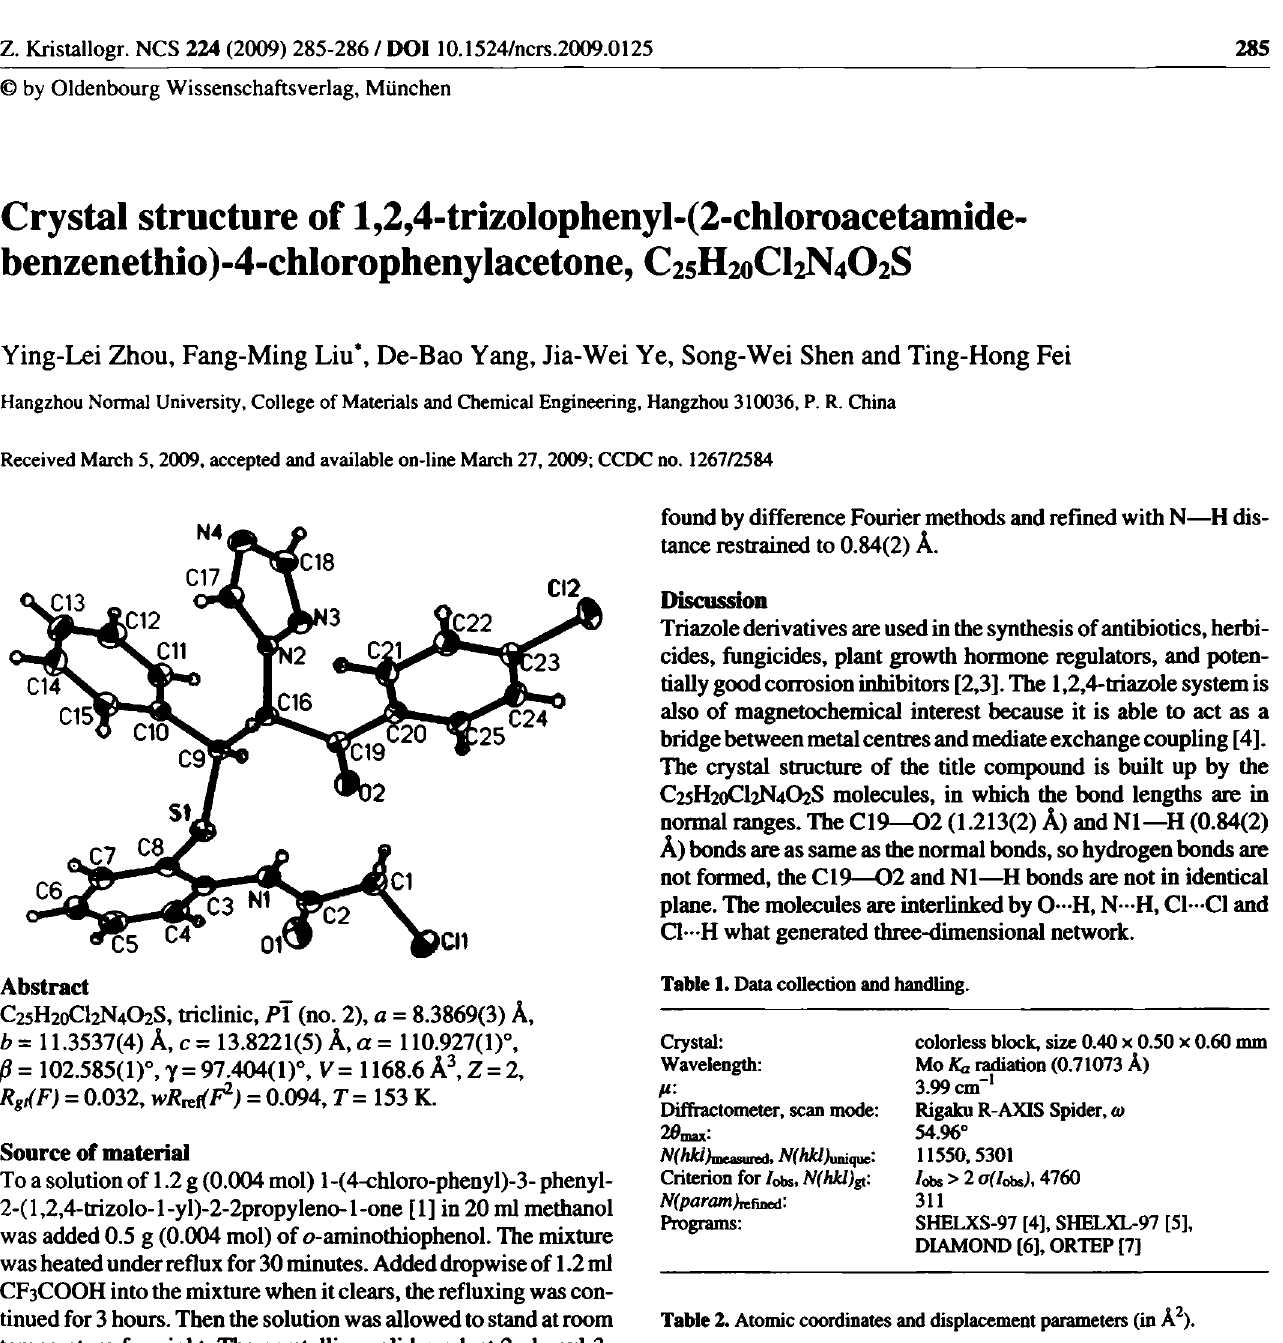
Table 2. Atomic coordinates and displacement parameters (in Â 2